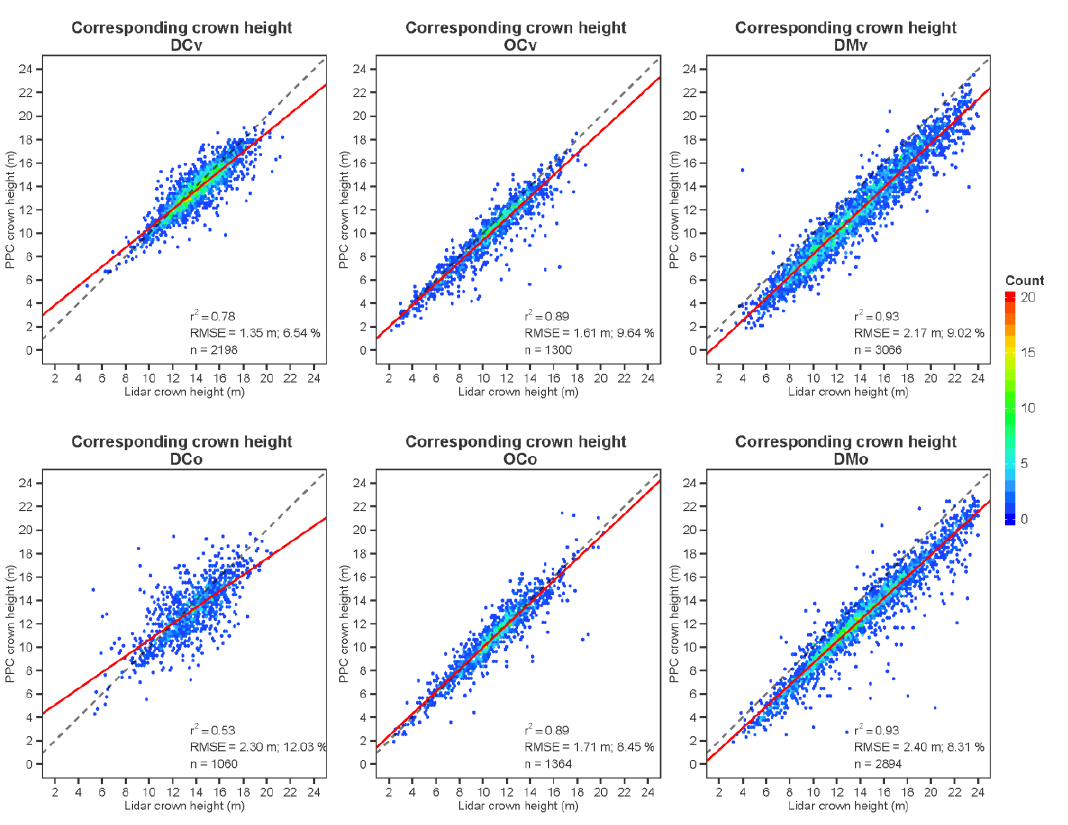
Figure 9. Scatterplots of the lidar and PPC-based tree heights (red line represents the slope of the relationships and dashed line represents the 1:1